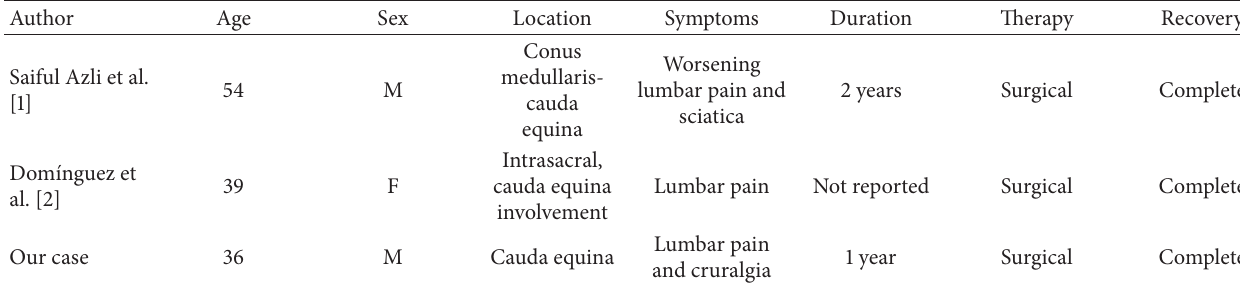
Table 1: The cases reported in